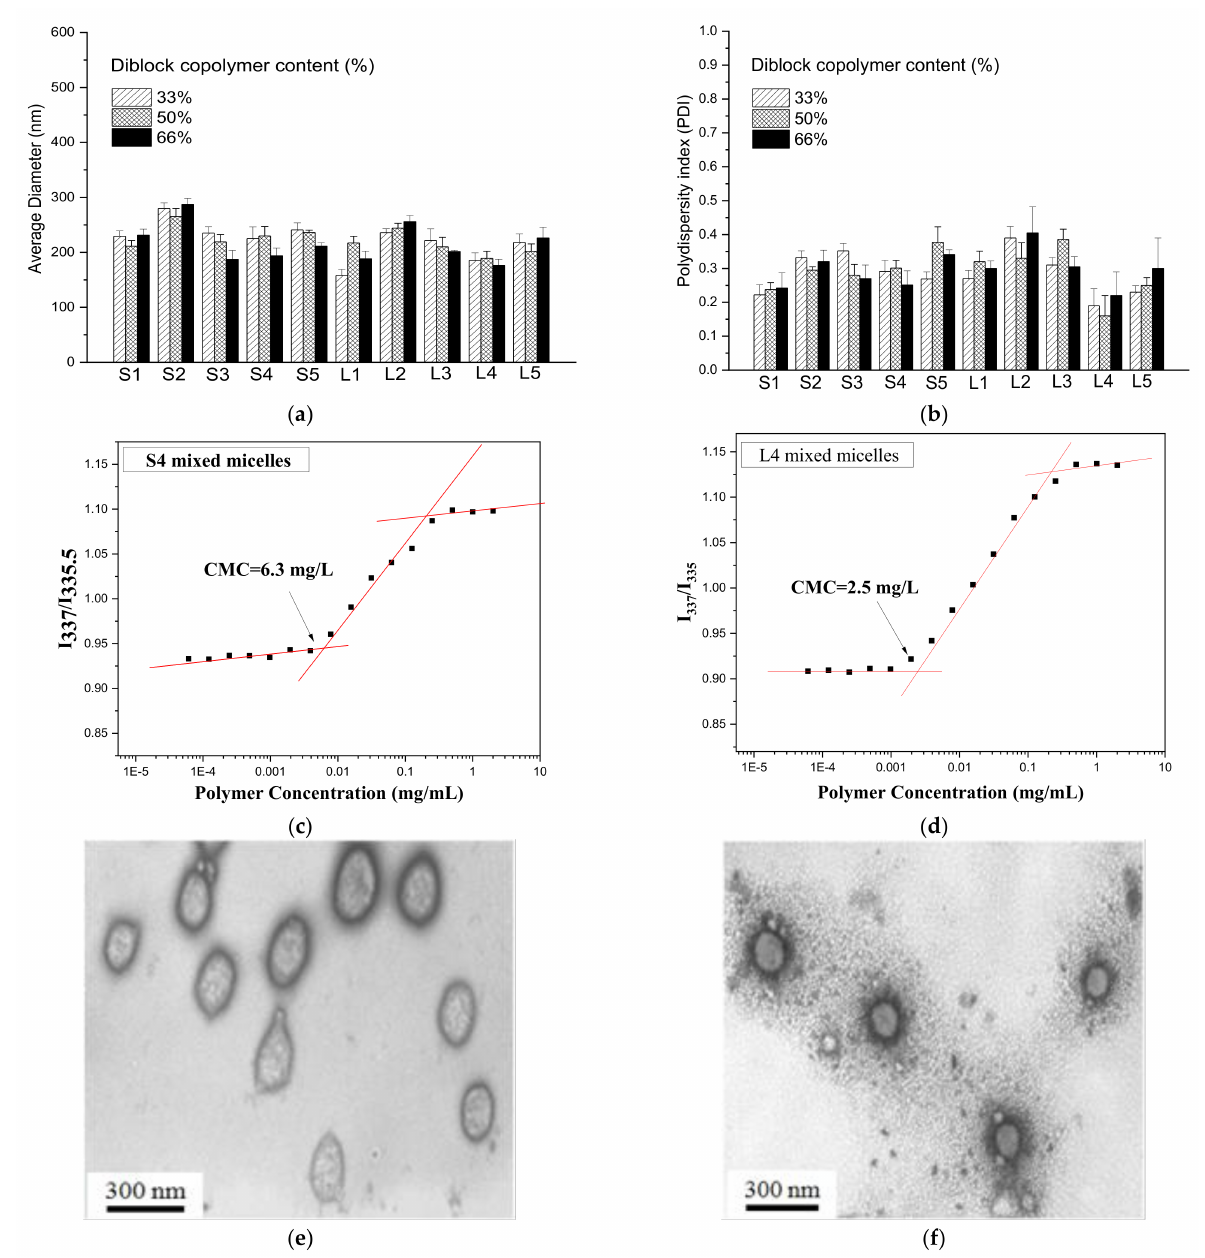
Figure 1. Characterization of the mixed micelles. ( a ) The particle sizes and ( b ) PDI values of the mixed micelles with various weight ratios of the diblock and graft copolymers. The CMC values of ( c ) S4 and ( d ) L4 polymeric mixed micelles, which were determined via a fluorescent pyrene probe. ( e ) S4. and ( f ) L4 polymeric mixed micelles after staining with 2% uranyl acetate were observed using